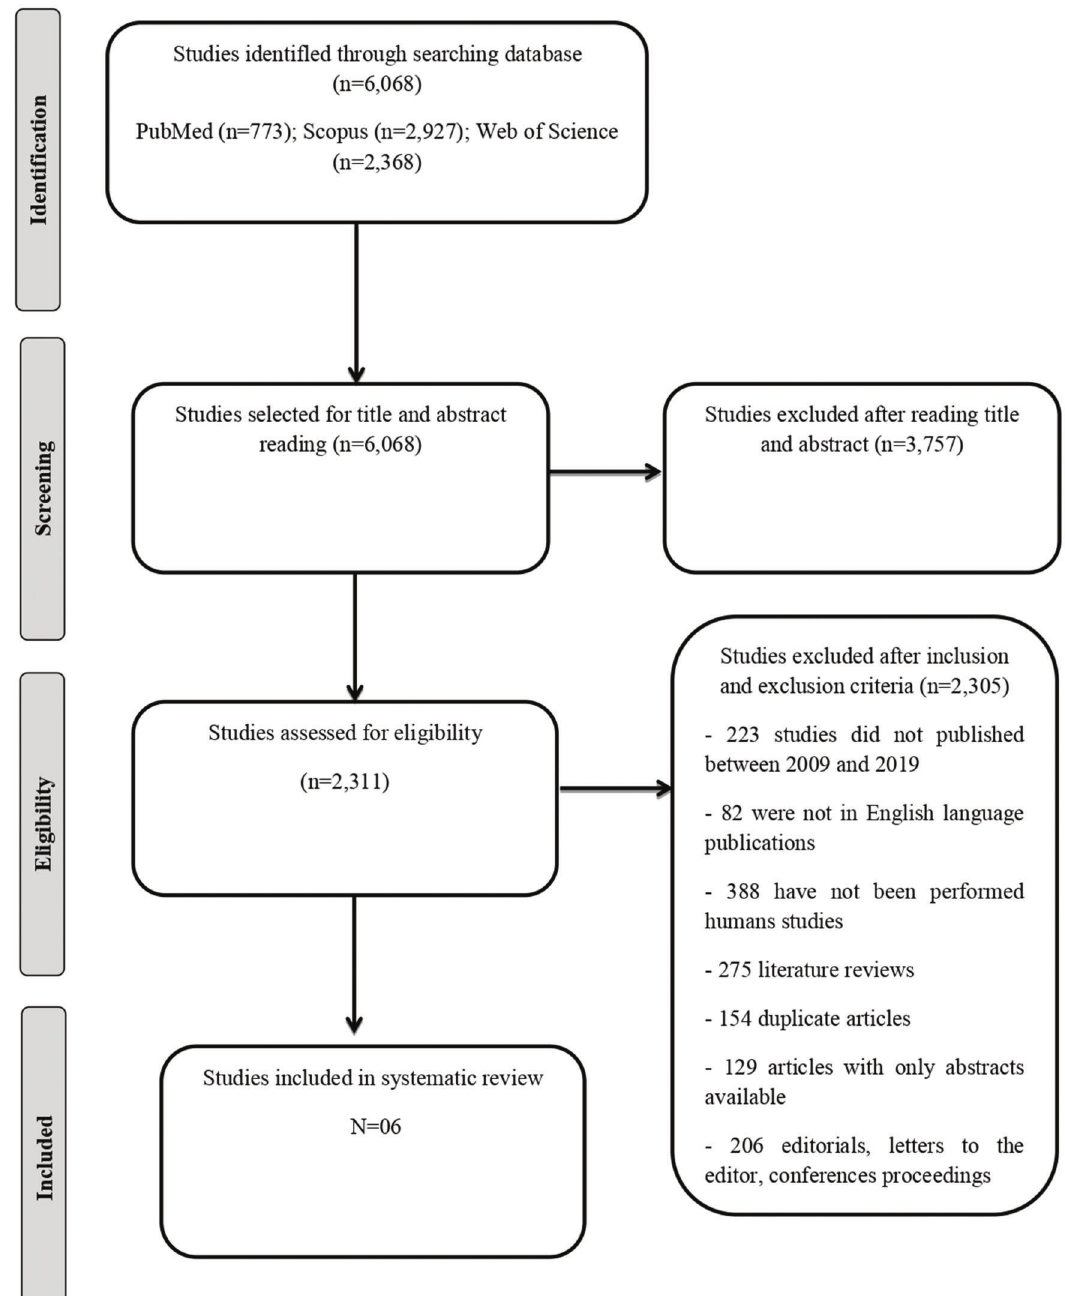
Figure 1 - Flow chart detailing the process of identification, selection, eligibility, and final inclusion of the